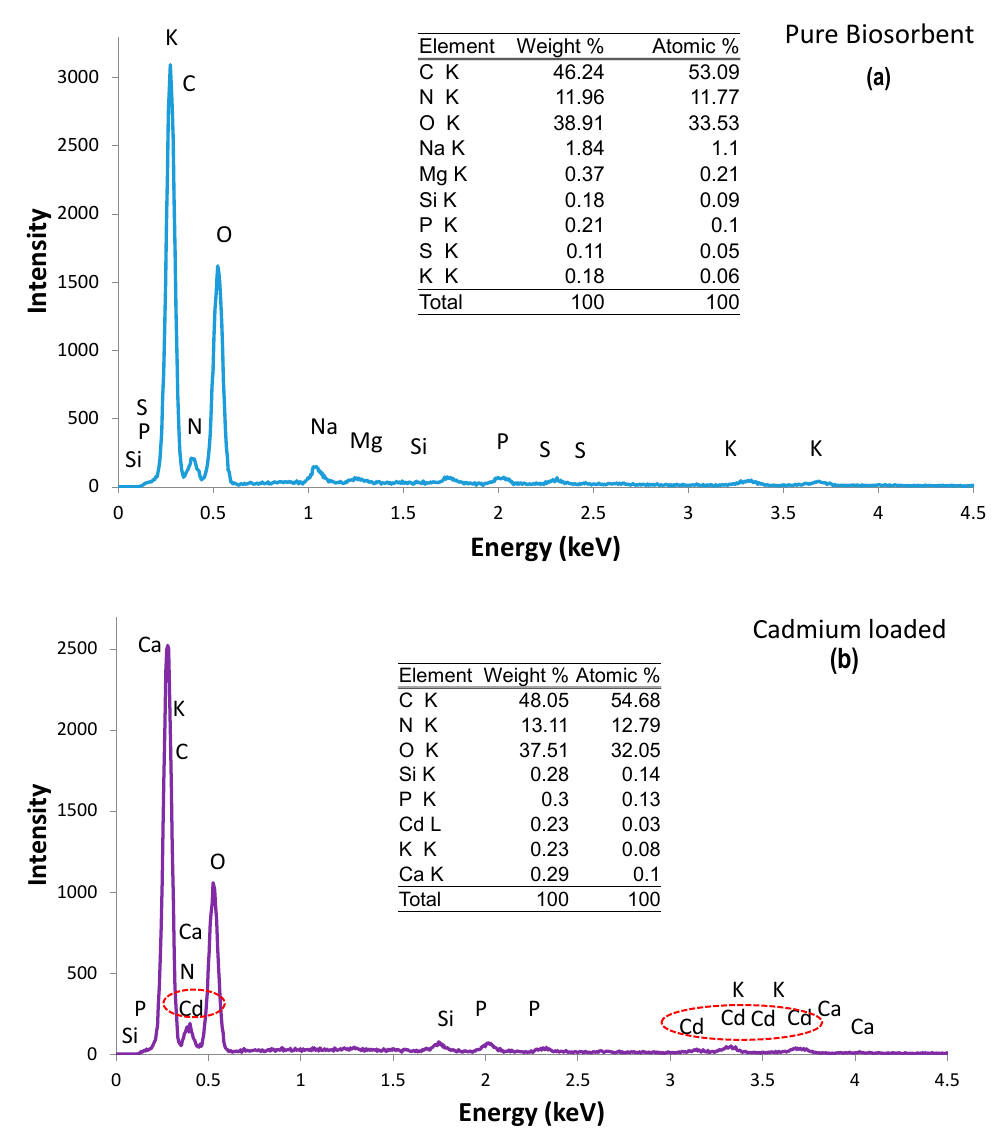
Figure 3. EDX spectra of dried biosorbent of Aphanothece sp. ( a ) before sorption and ( b ) after sorption using initial Cd concentration of 3 mg/L.